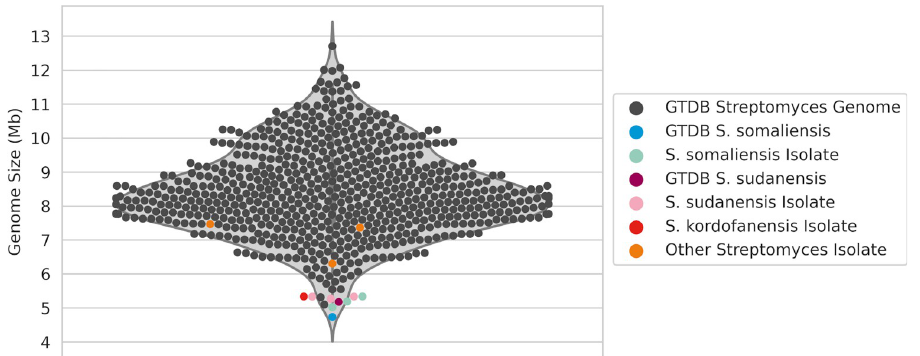
Fig 6. The distribution of genome sizes (in Mb) of all species within the Streptomyces genus (as defined by GTDB) for which a high quality genome is available (see materials and methods). The mean genome size for the genus is 8.45Mb. The genomes of all S . sudanensis and S . somaliensis related isolates are amongst the smallest genomes in the genus.